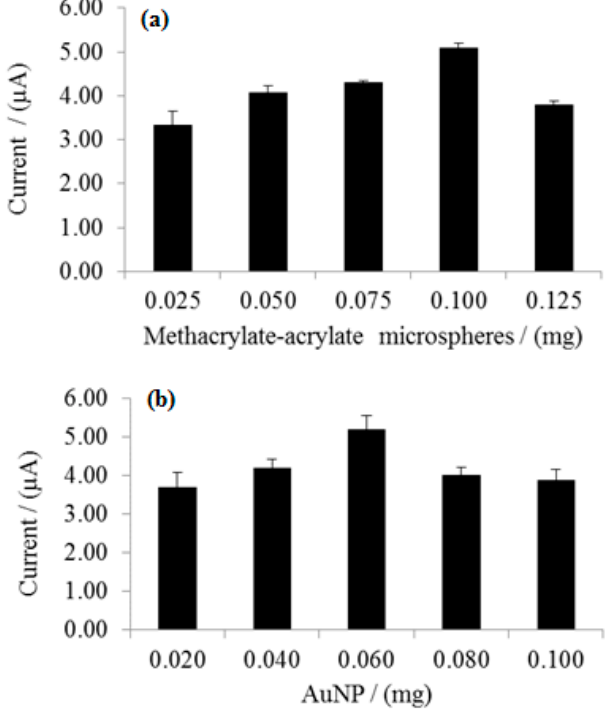
Figure 4. Anodic peak currents of 0.5 µ M Tartrazine on the surface of modified electrode with various amounts of ( a ) methacrylate-acrylate microspheres and ( b ) quantity of AuNPs. Error bar represents the standard deviation of triple measurements.